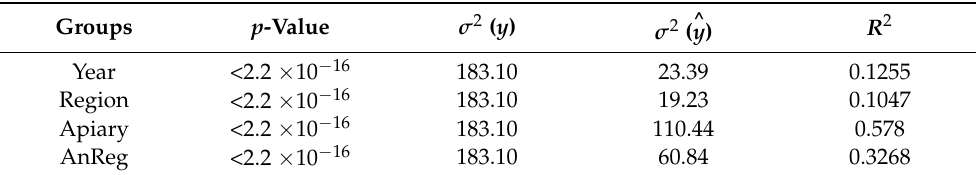
Table 1. Estimation of the proportion of the response variable y by each of the group factors (year, region, apiary, AnReg).